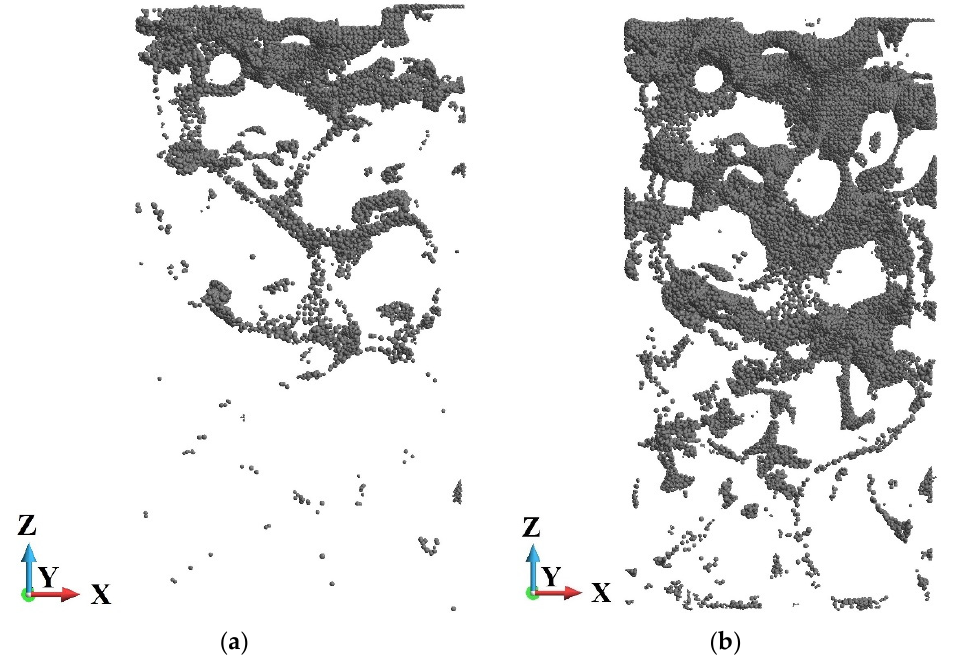
Figure 17. Points at which damage variable is higher than 0.95 at the end of the process: ( a ) piston velocity V = 40 m/s; ( b ) piston velocity V = 440 m/s.